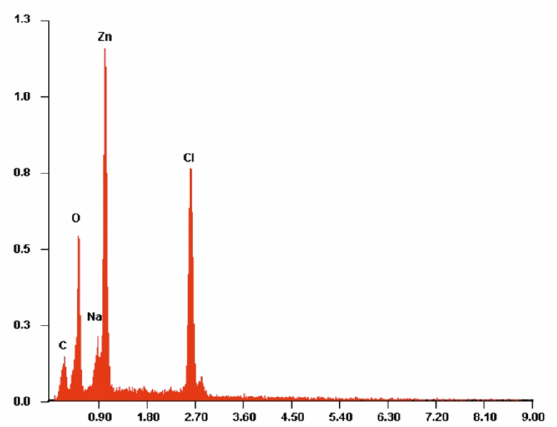
Figure 8. Example of the energy-dispersive X-ray spectroscopy (EDS) spectrum of PLA-ALG-Na (+) .